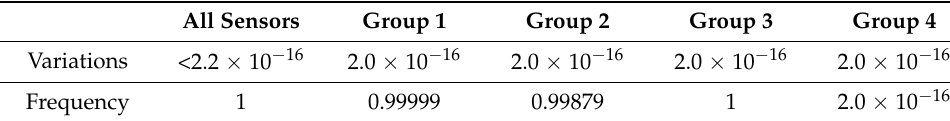
Figure 21. Boxplot for sensors of group 4. Table 4. Analysis of deviance— p -value.